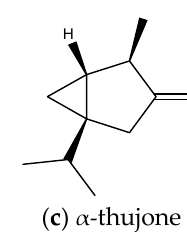
Figure 1. The main compounds in hydrolates. Table 1. Qualitative and quantitative analysis (%) of salvia hydrolates by GC/MS. RI b